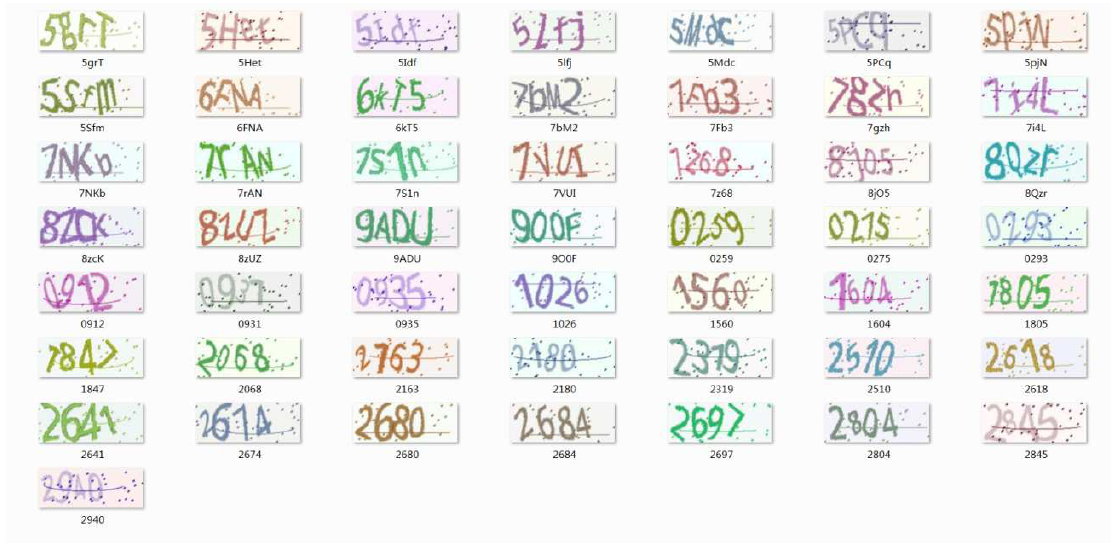
Figure 1. The captchas generated by one traditional text captcha generation method.